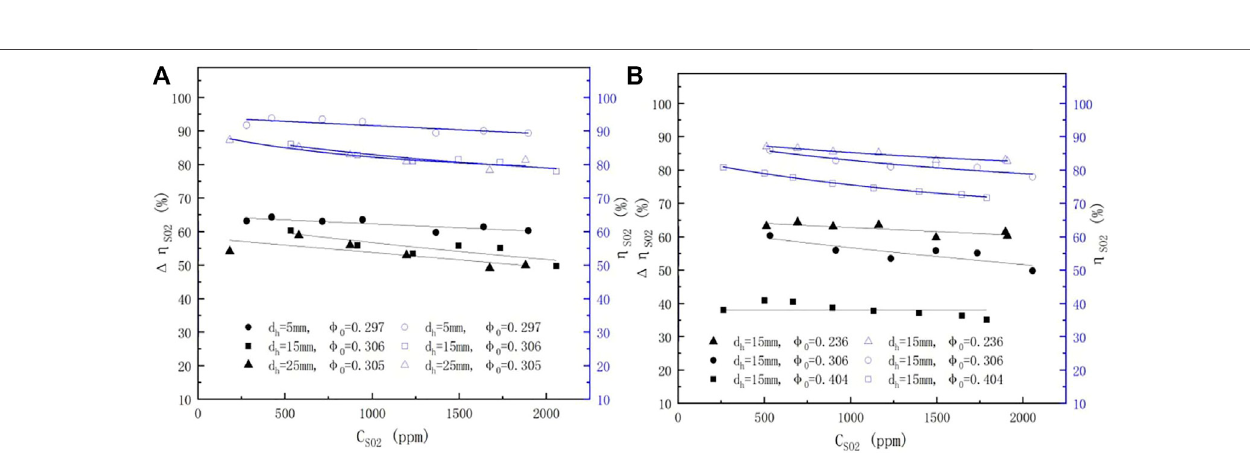
FIGURE 8 | Δη SO2 and η SO2 under different SO 2 concentrations (V L = 1.60 m 3 /h, V G = 95 m 3 /h, and pH = 6), (A) pore diameter, and (B) porosity.